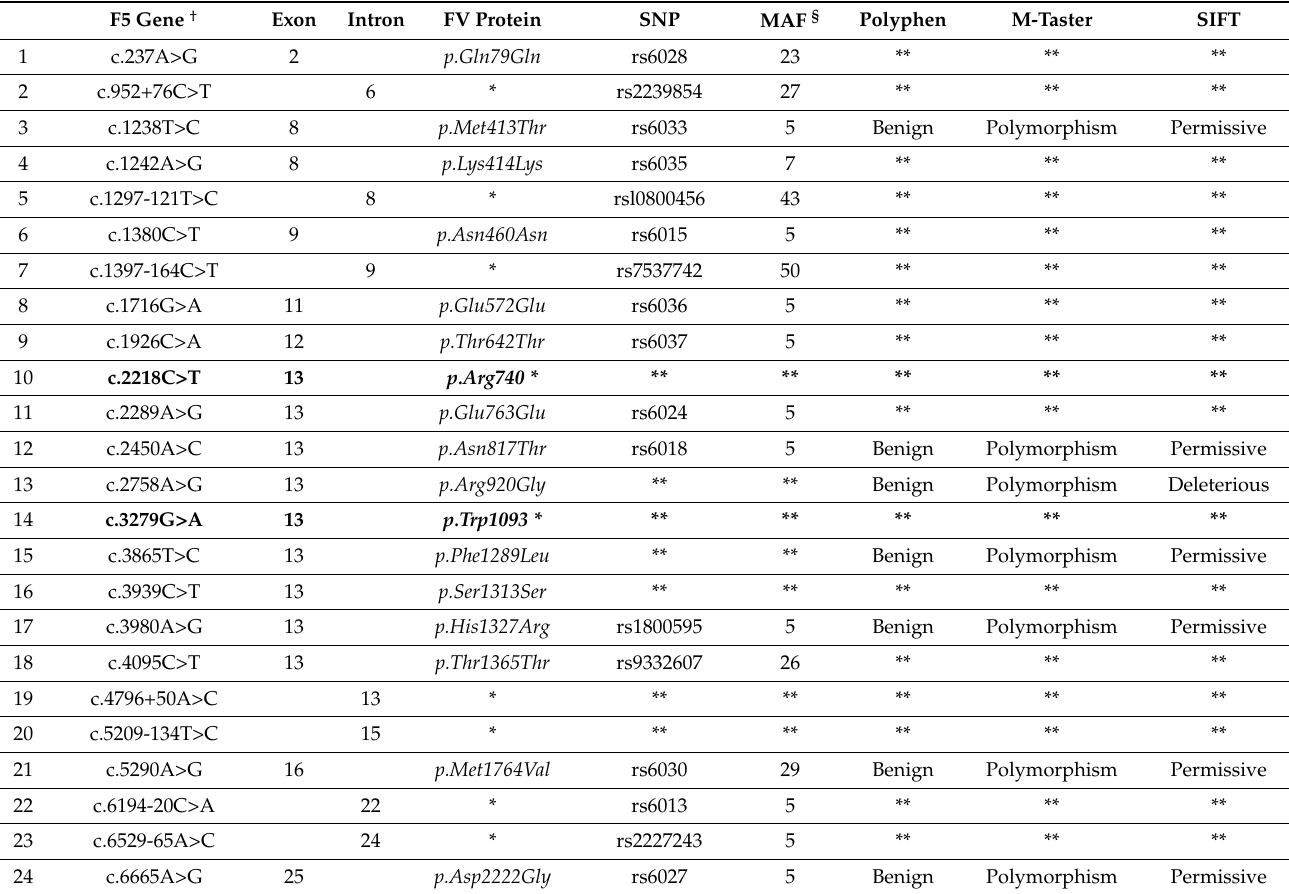
Table 2. Genetic variants identified in the F5 gene in patient A.